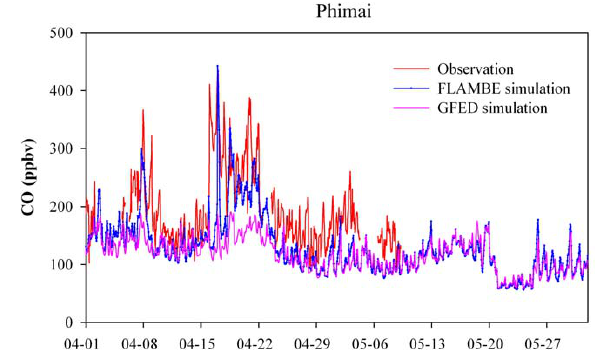
Fig. 2. Model Performance of the temporal CO concentrations with Figure 2. Model Performance of the temporal CO concentrations with two different biomass two different biomass burning emission inventories during 1 April burning emission inventories during April 1 to May 31, 2006 at Phimai, Thailand. to 31 May 2006 at Phimai, Thailand. The red line represents the ob- The red line represents the observation data, and the blue and purple lines represent servation data, and the blue and purple lines represent the modeled the modeled CO concentration by using the FLAMBE and GFEDv2.1 biomass CO concentration by using the FLAMBE and GFEDv2.1 biomass burning emissions, respectively. burning emissions,